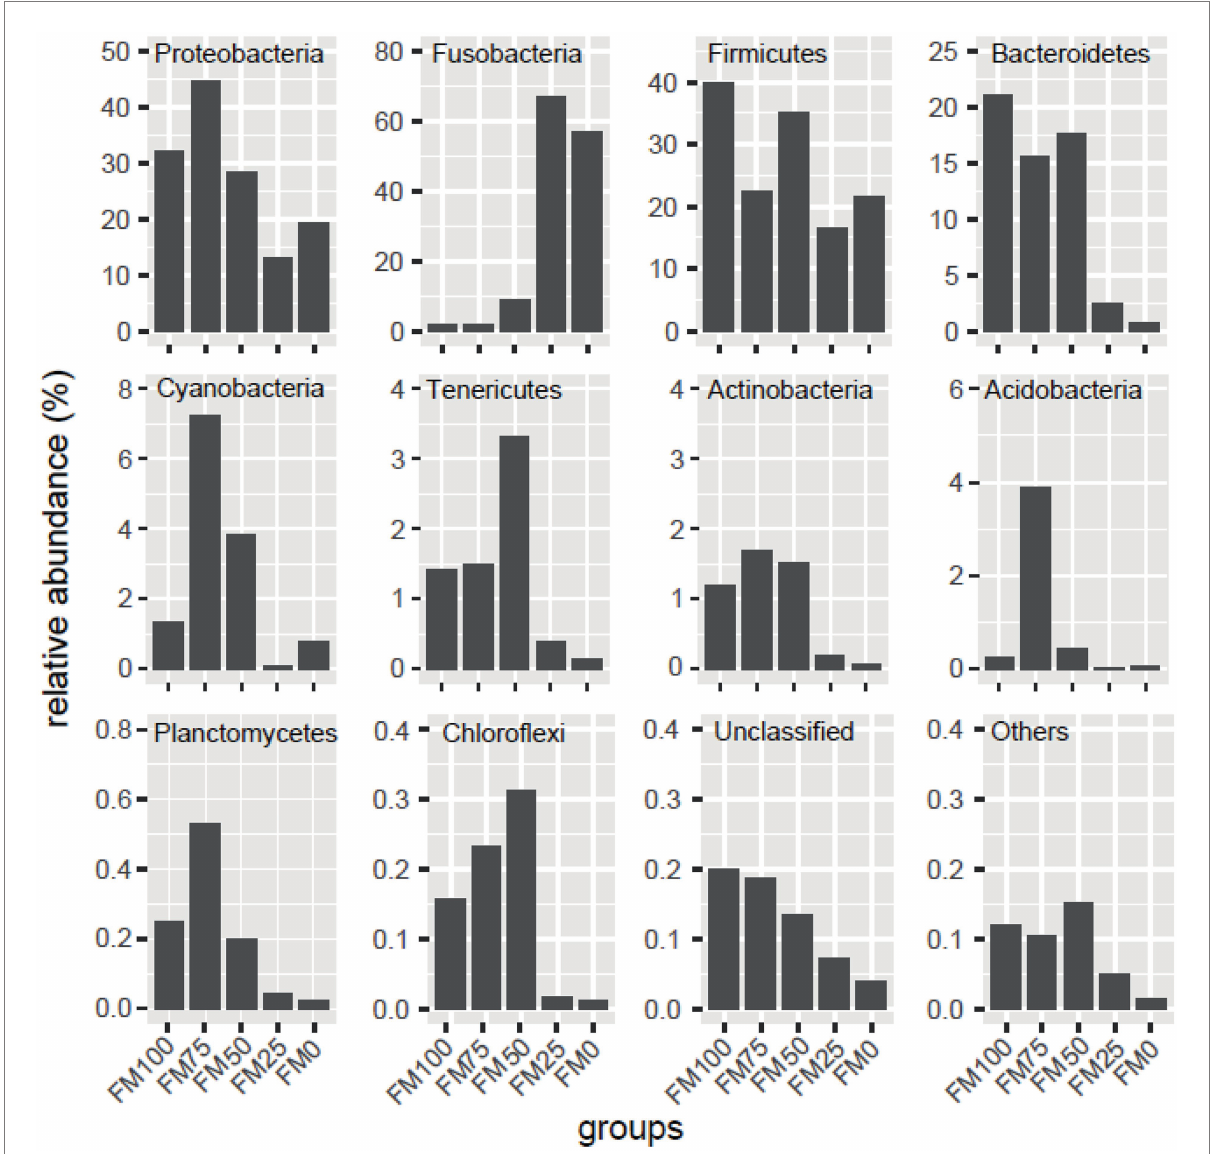
FIGURE 3 Taxonomic distribution of gut microbial community at the phylum levels among the five groups of largemouth bass. Unclassified, the unclassified phyla; others, the other known phyla. FM100 represents the fishmeal diet without Chlorella meal; FM75, FM50, FM25, and FM0 represent the fishmeal diet with 25, 50, 75, and 100% fishmeal replacement by Chlorella meal,